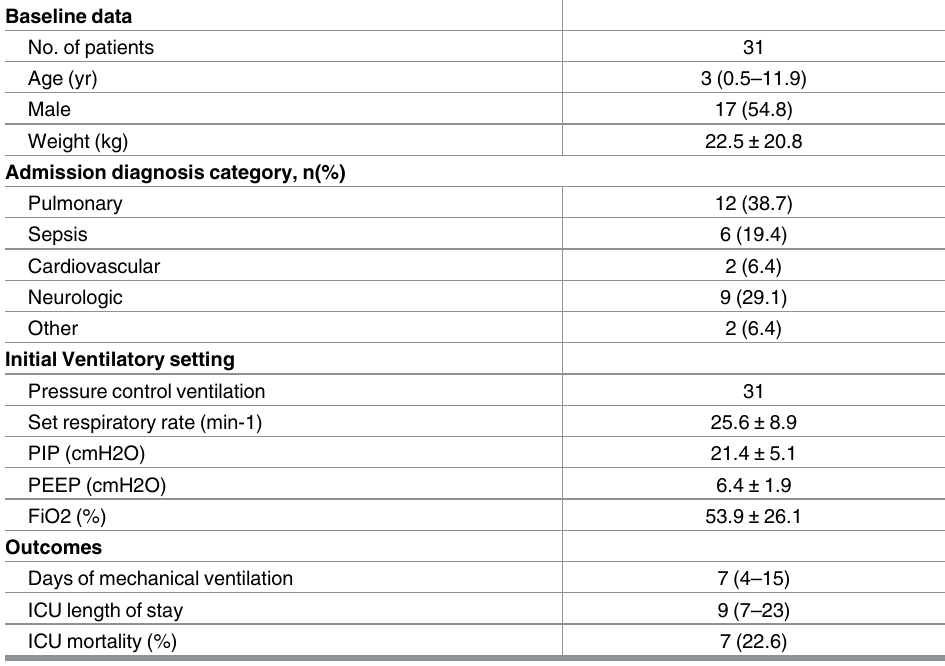
Table 1. Demographics of intubated children admitted to the